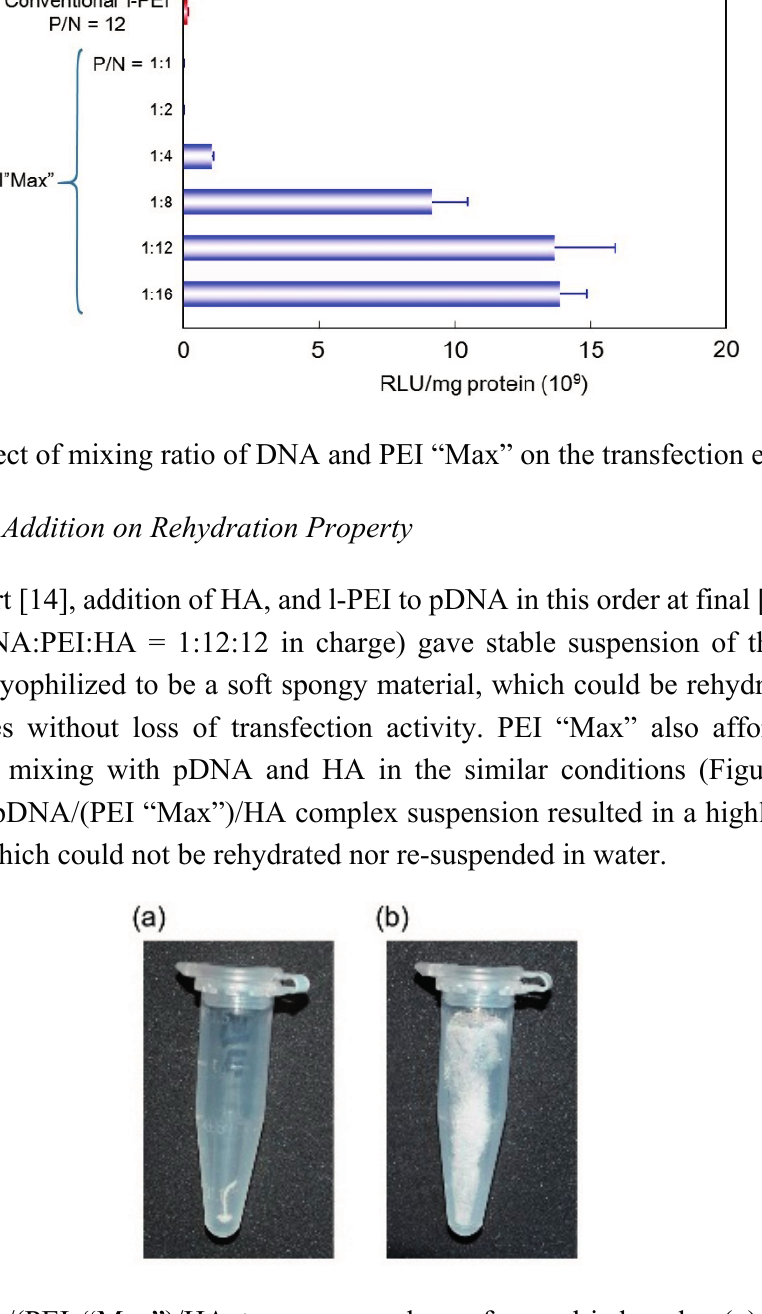
Figure 2. DNA/(PEI “Max”)/HA ternary complexes freeze-dried under ( a ) absence or ( b ) presence of 0.1%